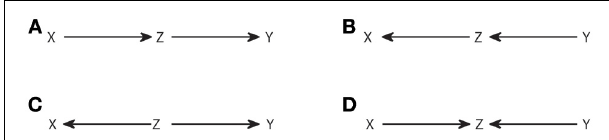
FIGURE 1 | Observationally equivalent causal structures. The causal structures (A–C) are observationally equivalent, while the one in (D) is distinguishable from